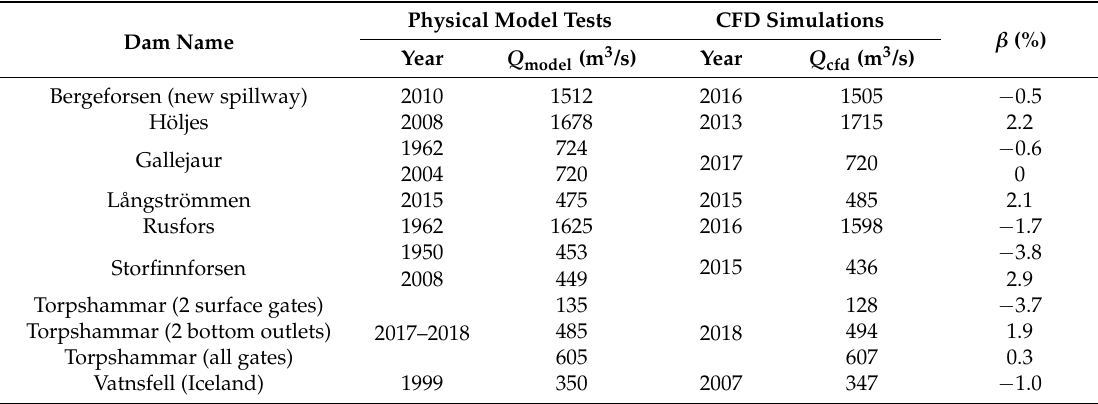
Table 5. Prediction of spillway discharge, comparison between CFD and physical tests.